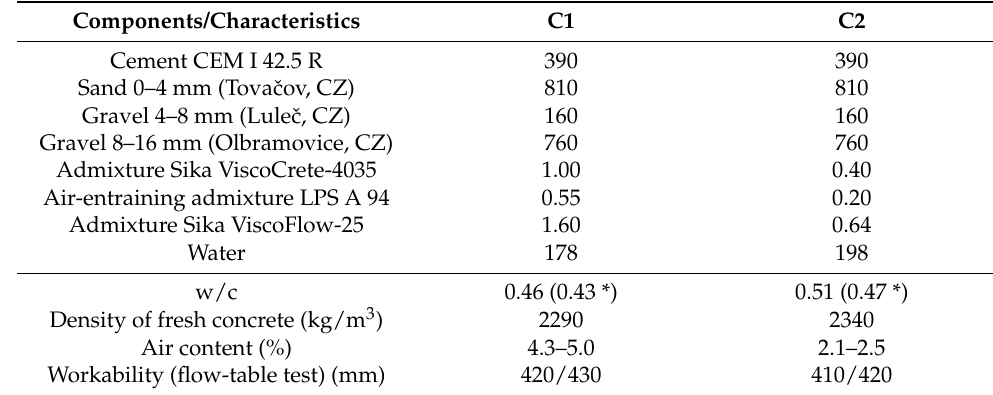
Table 1. Composition of C1 and C2 concrete in kg per 1 m 3 of fresh concrete and basic characteristics of fresh concretes.